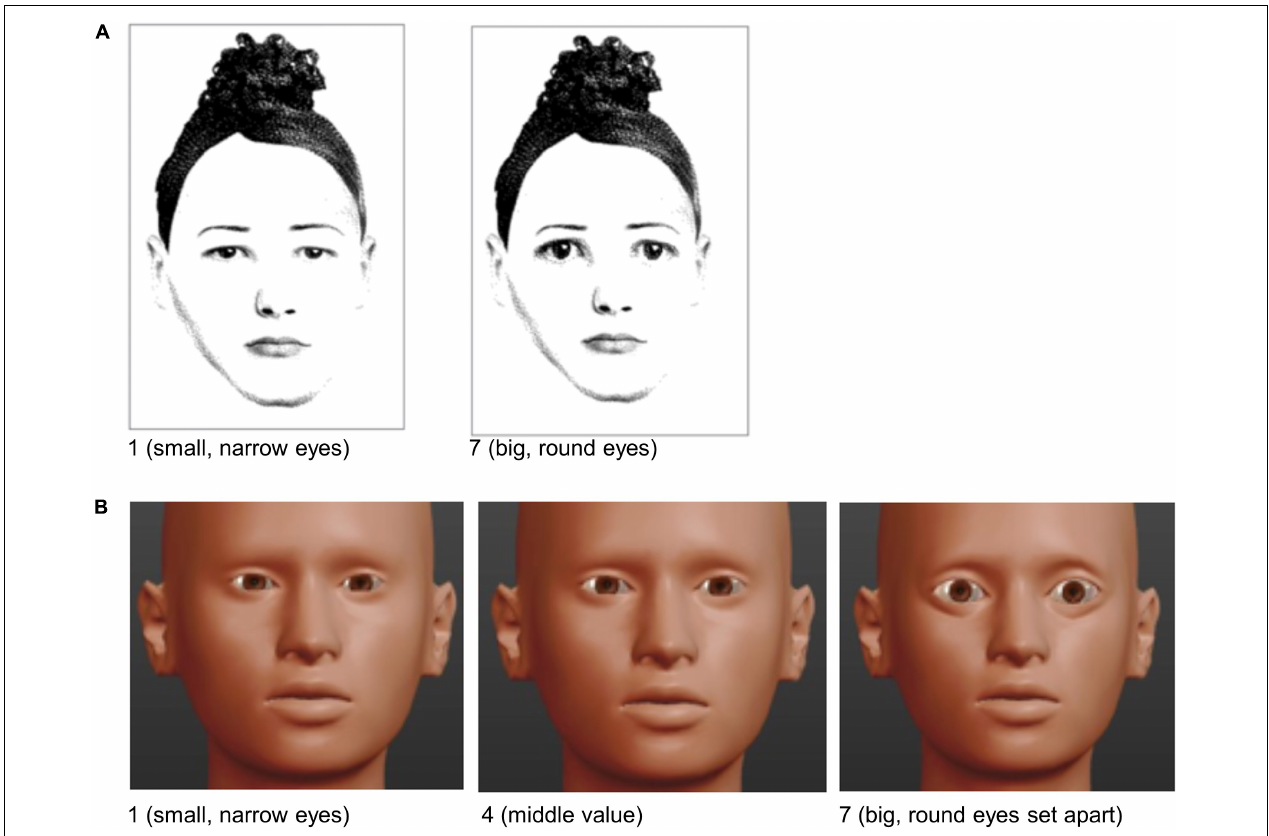
FIGURE 1 | Example excerpt from the two versions of the rating manual for the babyfacedness subfacet eyes . (A) Displays the extreme values for “not babyfaced” (i.e., small and narrow eyes) in contrast to “babyfaced” (i.e., big and round eyes) from the first version of the manual. (B) Displays extreme values from the revised manual, including an example of mid-ranged babyfaced